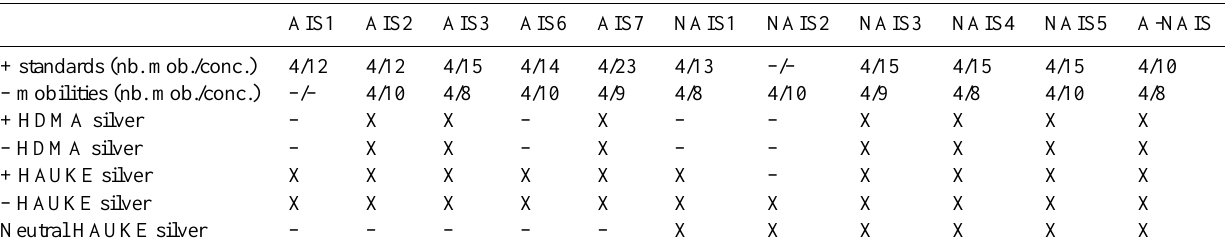
Table 1. Tasks performed for each ion spectrometer. The signs + and – in the task represent positive and negative polarities, “–” means not done or not possible, and the “X” sign means that the task was performed. In the first two rows (standards and mobilities) the number of mobility standards used is shown on the left, and the number on the right expresses the total number of different mobility and concentration combinations. AIS1 AIS2 AIS3 AIS6 AIS7 NAIS1 NAIS2 NAIS3 NAIS4 NAIS5 A-NAIS + standards (nb. mob./conc.) 4/12 4/12 4/15 4/14 4/23 4/13 –/–